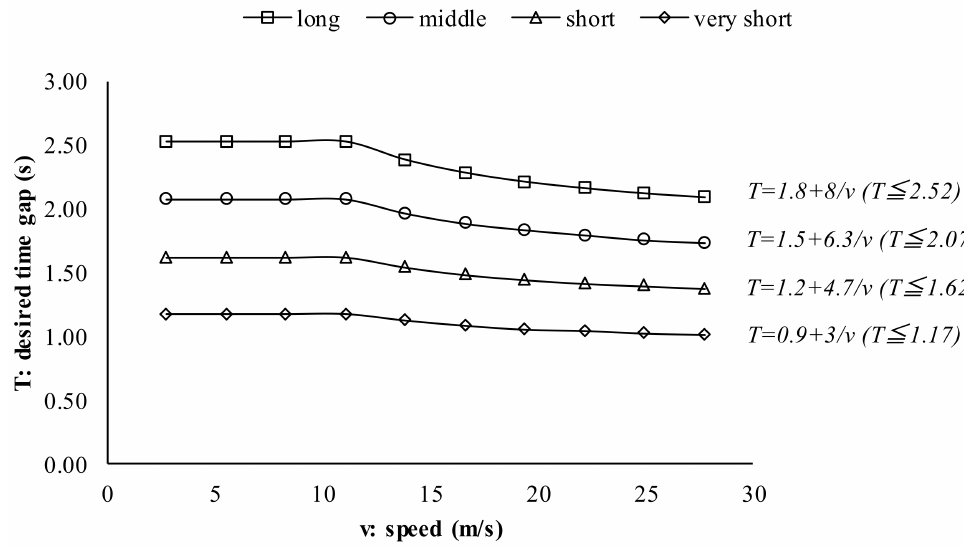
Figure 7. Time-gap control